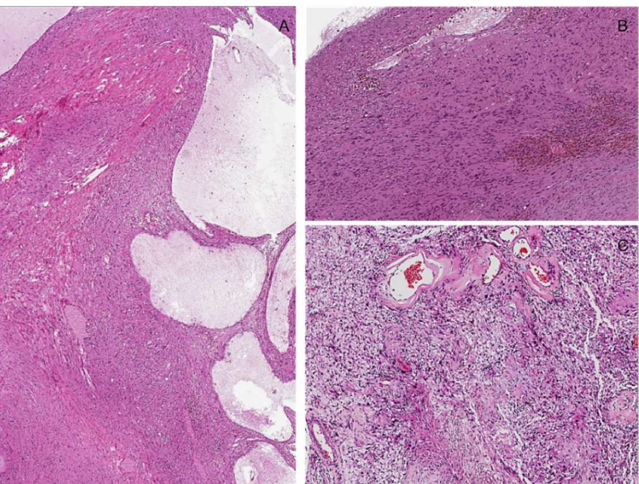
Figure 14. Schwannoma with “ ancient ” changes. ( A ) Low-magnification image showing cystic stromal changes and stromal hyalinization. ( B ) Hemorrhages can be observed intermingling with tumor cells that exhibit nuclear atypia. ( C ) Thick-walled vessels are